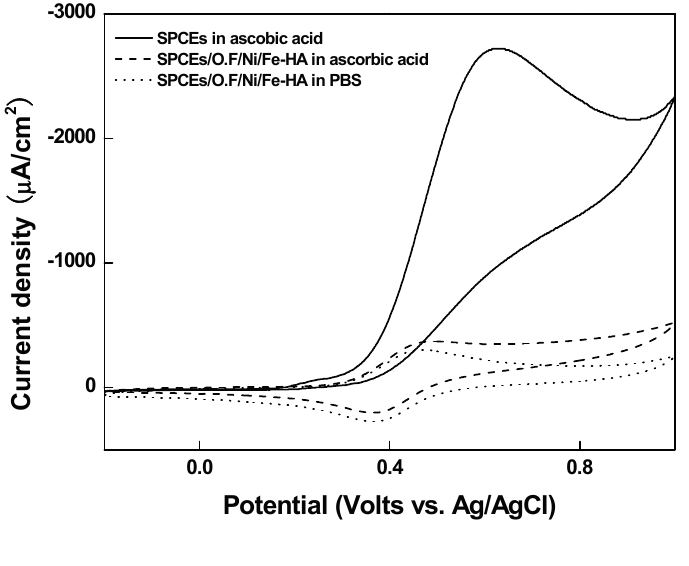
Figure 7. Cyclic voltammogram of the SPCEs/Organic film/Ni/Fe-HA in 2 mM ascorbic acid solution at scan rate of 0.10 V s − 1